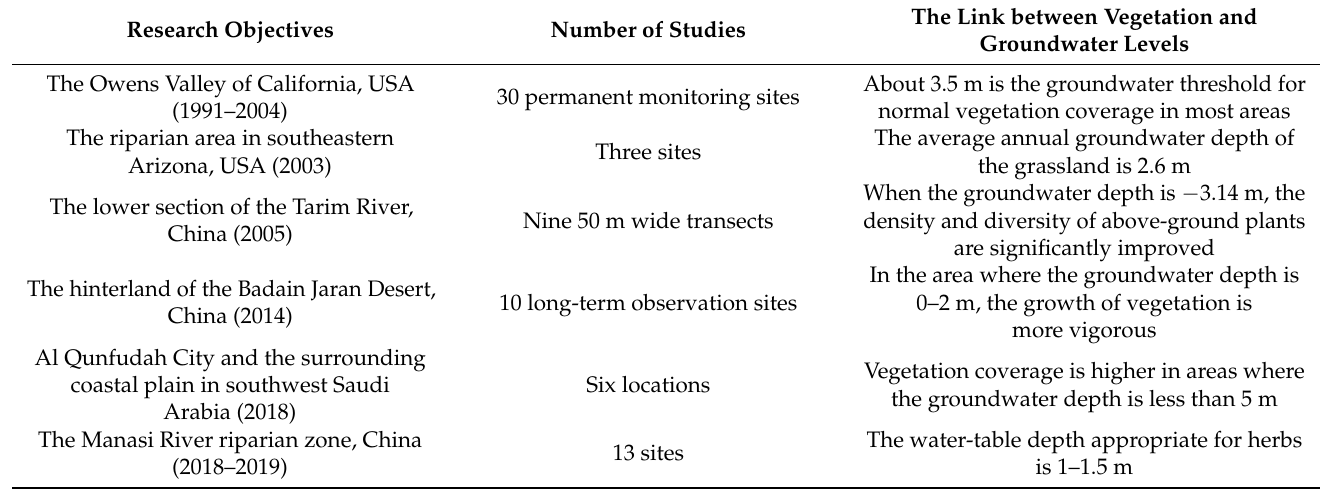
Table 4. Relationship between vegetation growth and groundwater level in different